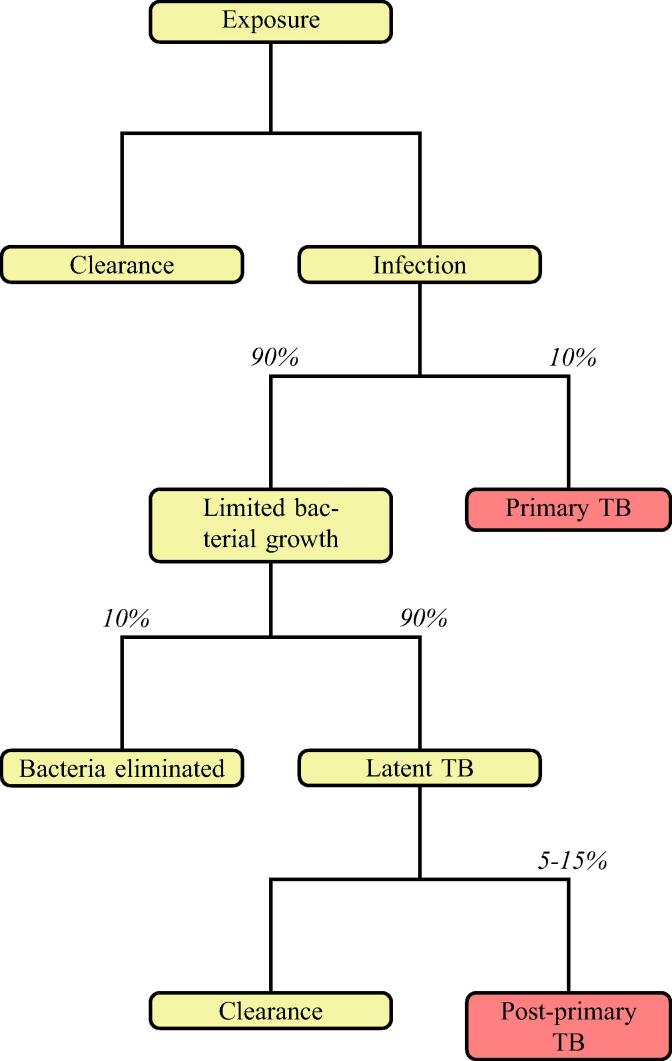
Overview of the clinical outcomes of M. tuberculosis exposure. Adapted from Ahmad (2011), values from World Health Organization, 2018, Ahmad, 2011. Red boxes indicate active, symptomatic disease.